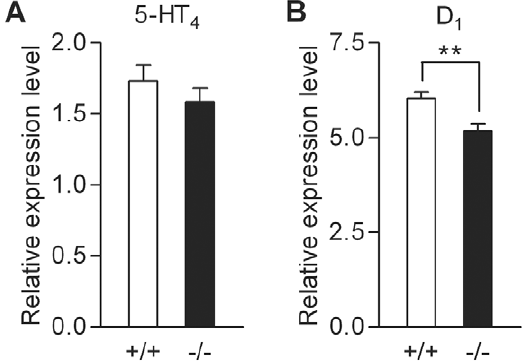
Figure 5. Reduced hippocampal expression of dopamine D1 receptor in sandy mice. (A) Expression levels of mRNAs for serotonin 5-HT 4 receptor relative to those of GAPDH in the hippocampus (n=10 each). (B) Relative expression levels of mRNAs for dopamine D 1 receptor in the hippocampus were reduced in mutant mice as compared with wild-type mice ( + / + : 6.04 6 0.17; 2 / 2 : 5.16 6 0.2, n=10 each; p =0.0068).